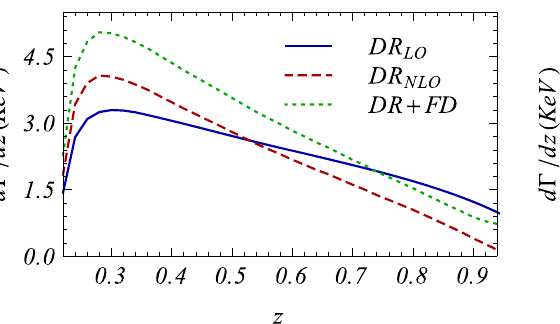
in the left diagram, and μ r = m Z in the right diagram. The super- scripts “DR” and “FD” denote the direct and feeddown contributions,